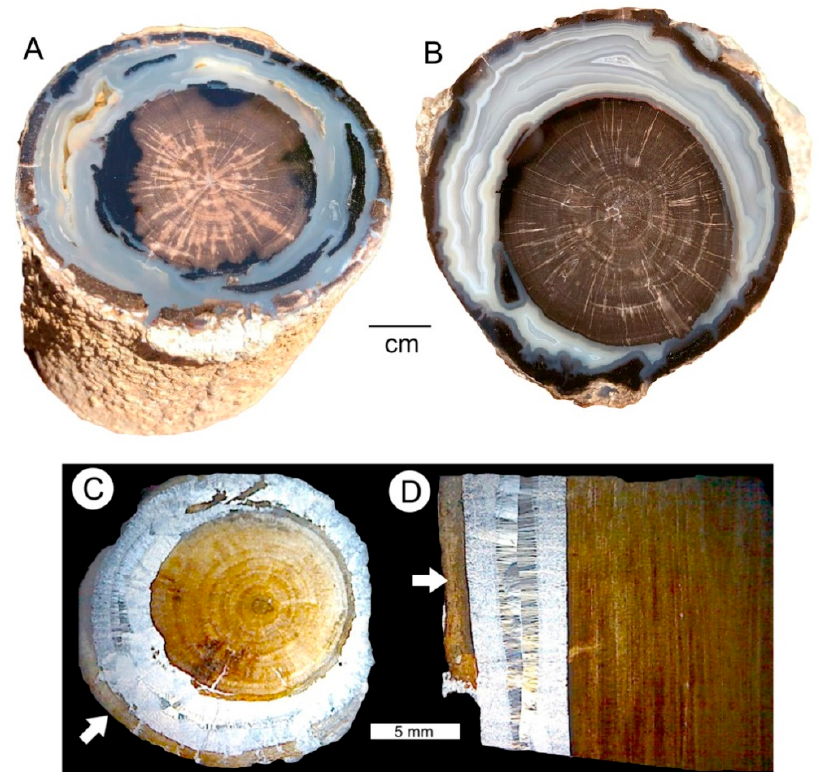
Figure 17. Secondary chalcedony. ( A , B ) Chalcedony filling peripheral zone caused by wood shrinkage. ( C , D ). Polarized light optical photomicrographs show separation of wood as a result of desiccation. Arrows show the bark layer, which remained attached to rock matrix.